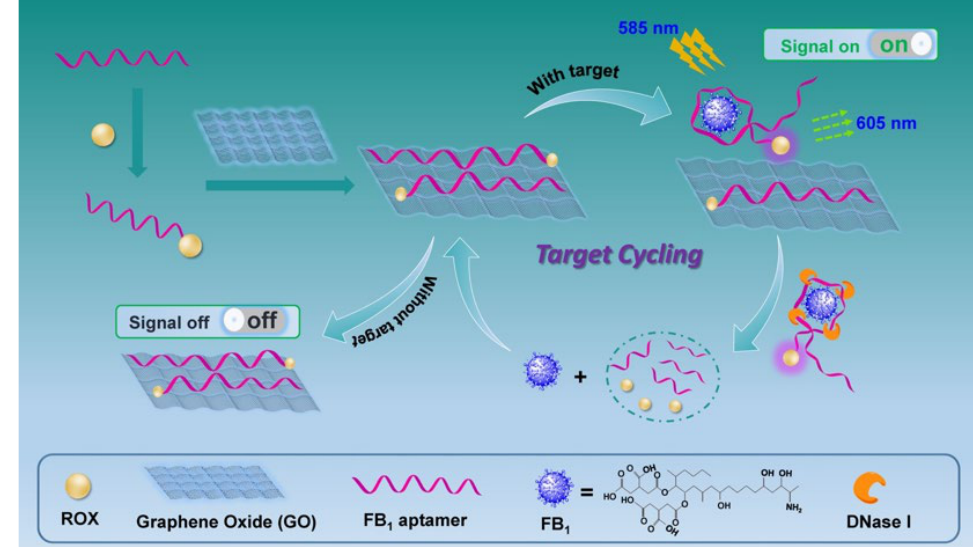
Figure 1. Schematic representation of the GO-assisted fluorescent aptasensor platform for detection of fumonisin B 1 via the utilization of nuclease triggered signal-on performance and the specific aptamer.